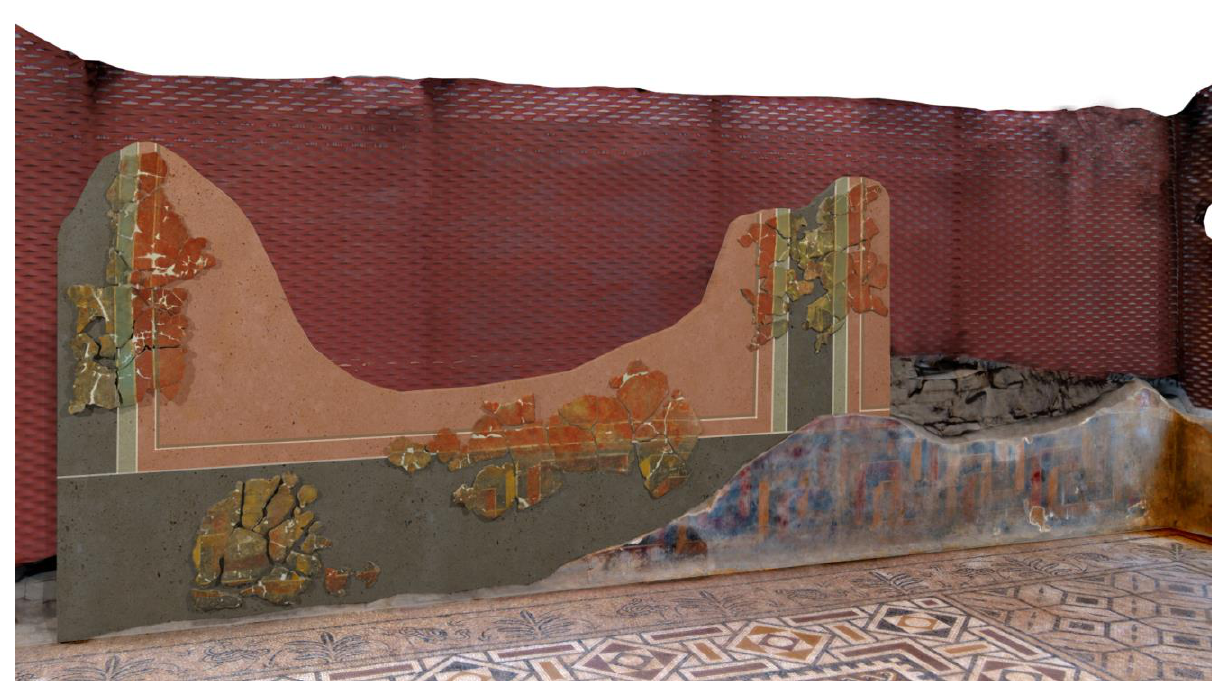
Figure 5. Final image rendered image of the room, including the chromatic reintegration of the intervention